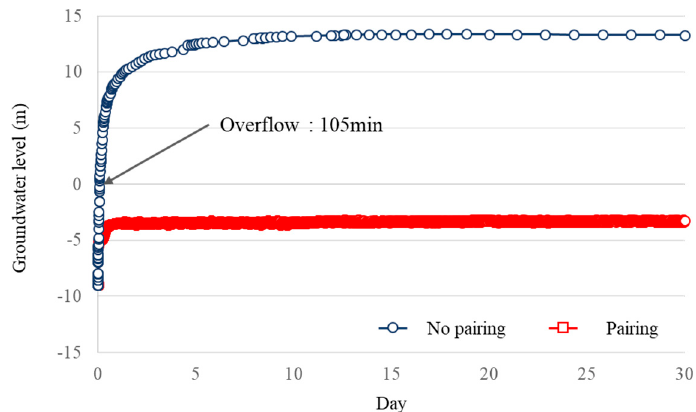
Figure 11. Groundwater level at the injection well in the condition of different hydraulic conductivities and pumping rates.